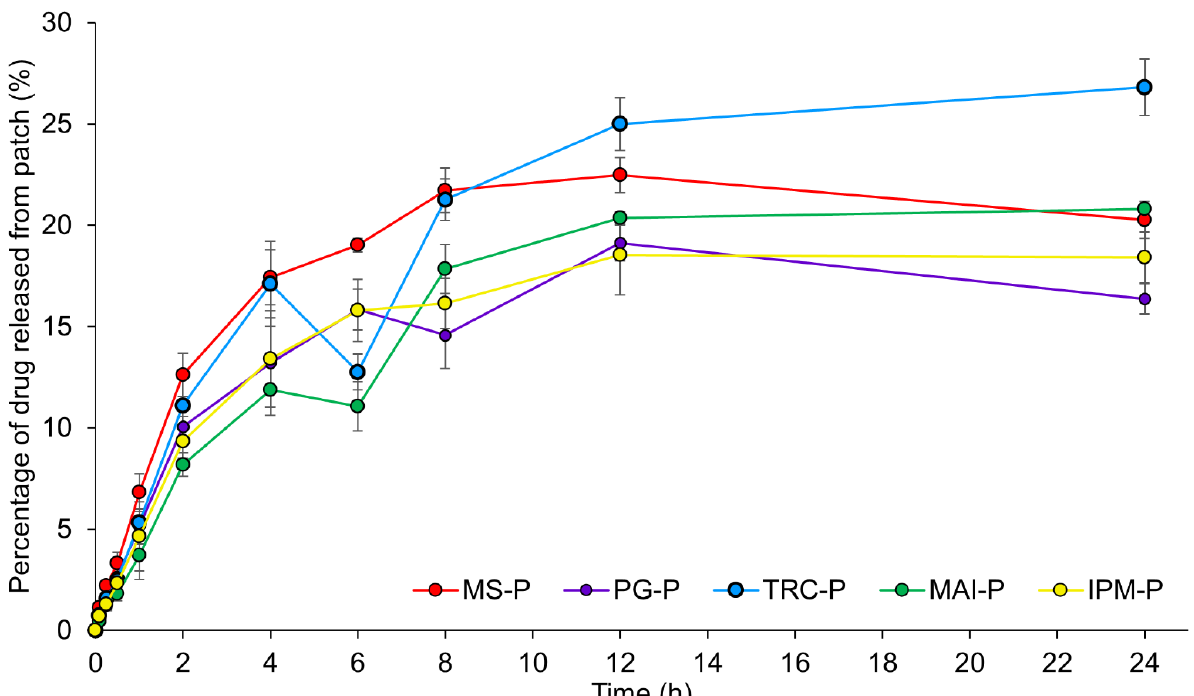
Figure 5. In vitro release studies of MS-loaded patches with different solvents (PG: propylene glycol; TRC: Transcutol ® P; MAI: Maisine ® CC; IPM: isopropyl myristate) (n = 3, mean ± SD). MS: methyl salicylate; MS-P: patches with drug but without solvent; -P: patches with drug and solvent.